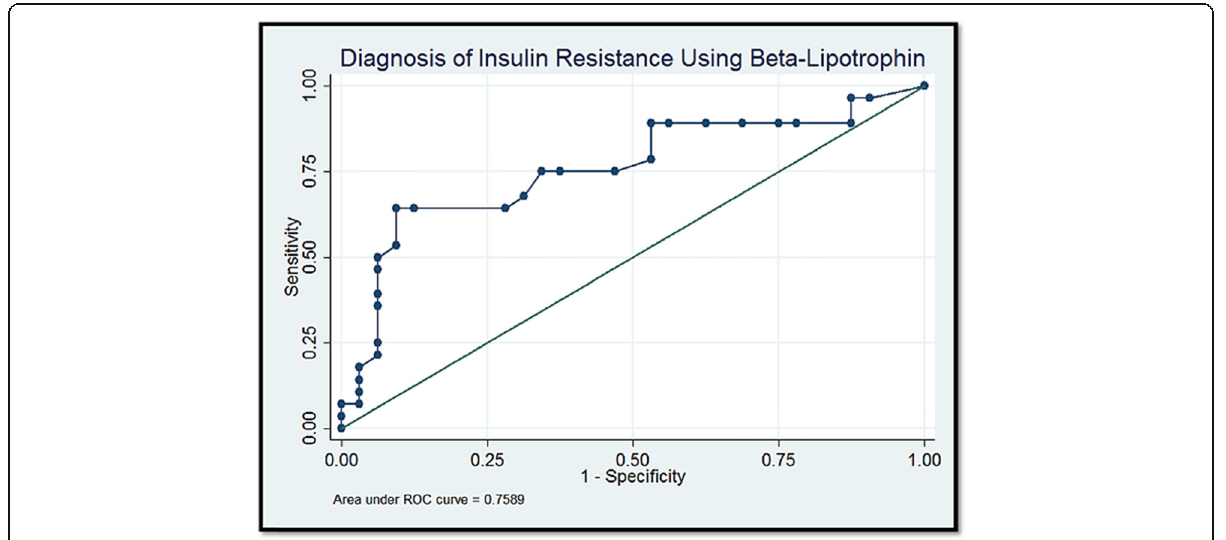
Fig. 4 ROC curve demonstrating the diagnostic performance of serum betatrophin in the prediction of insulin